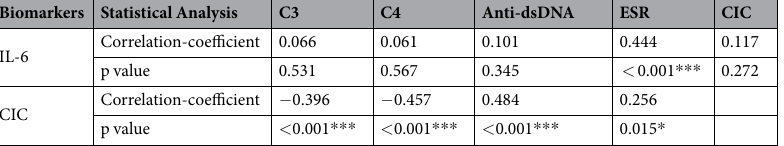
Table 4. Correlation of individual biomarkers * p < 0.05, ** p < 0.01, *** p < 0.001.